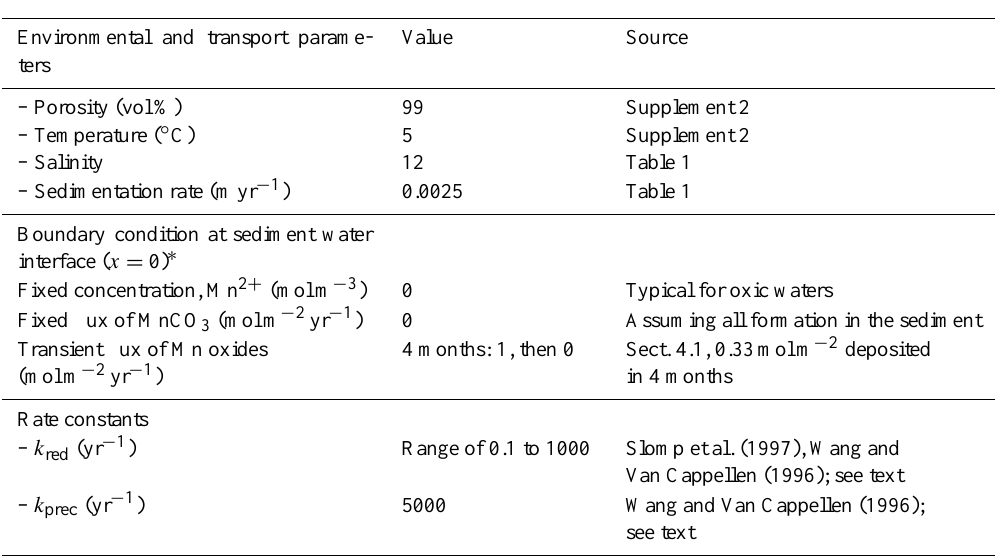
Table 3. Environmental parameters, boundary conditions (where x = 0 refers to the sediment–water interface and x = 1cm refers to a depth of 1cm in the sediment) and first-order rate constants used in the simple diagenetic model for Mn for a “typical” Gotland Basin sediment, including the sources, where